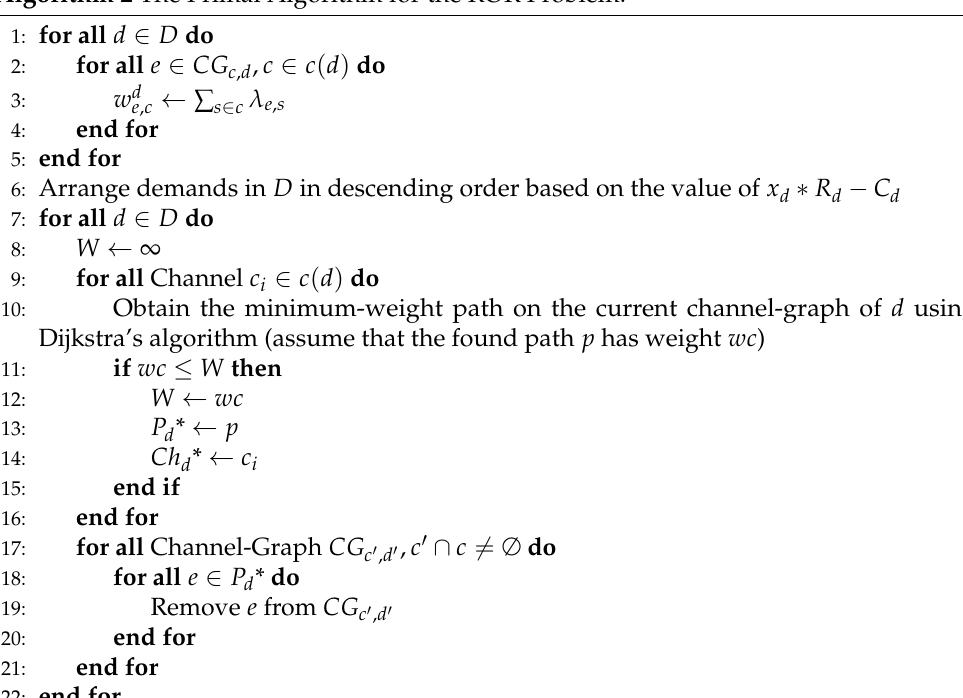
Algorithm 2 The Primal Algorithm for the ROR